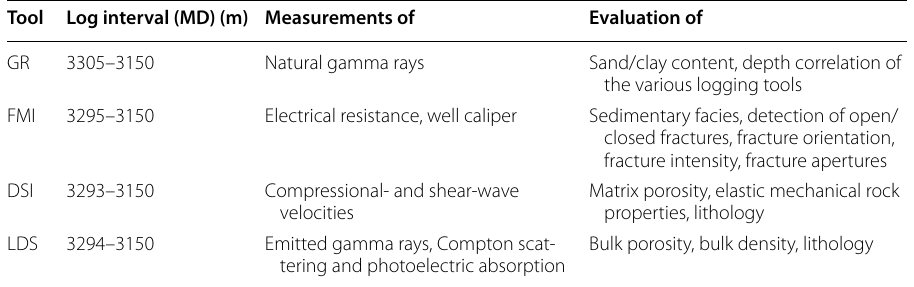
GR gamma ray, FMI formation micro imager, DSI dipole sonic imager, LDS litho density sonde, MD measured depth